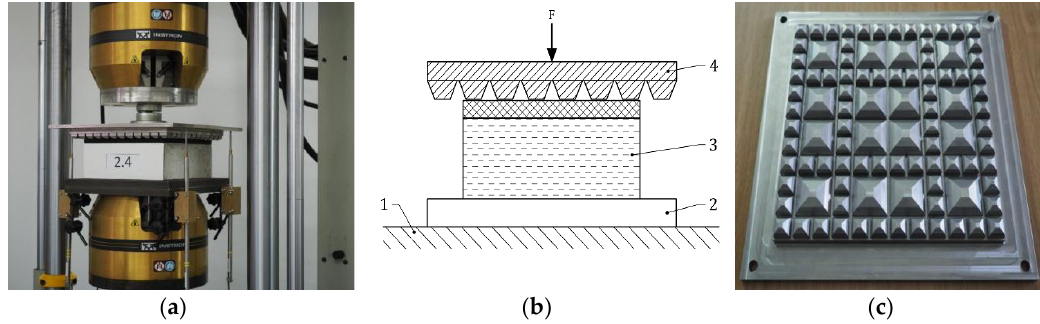
Figure 1. Testing procedure: ( a ) under sleeper pad (USP) sample attached to the concrete block; ( b ) test scheme (1 — non-deformable support, 2 — steel plate, 3 — USP on concrete block, 4 — GBP); ( c ) geometric ballast plate (GBP).